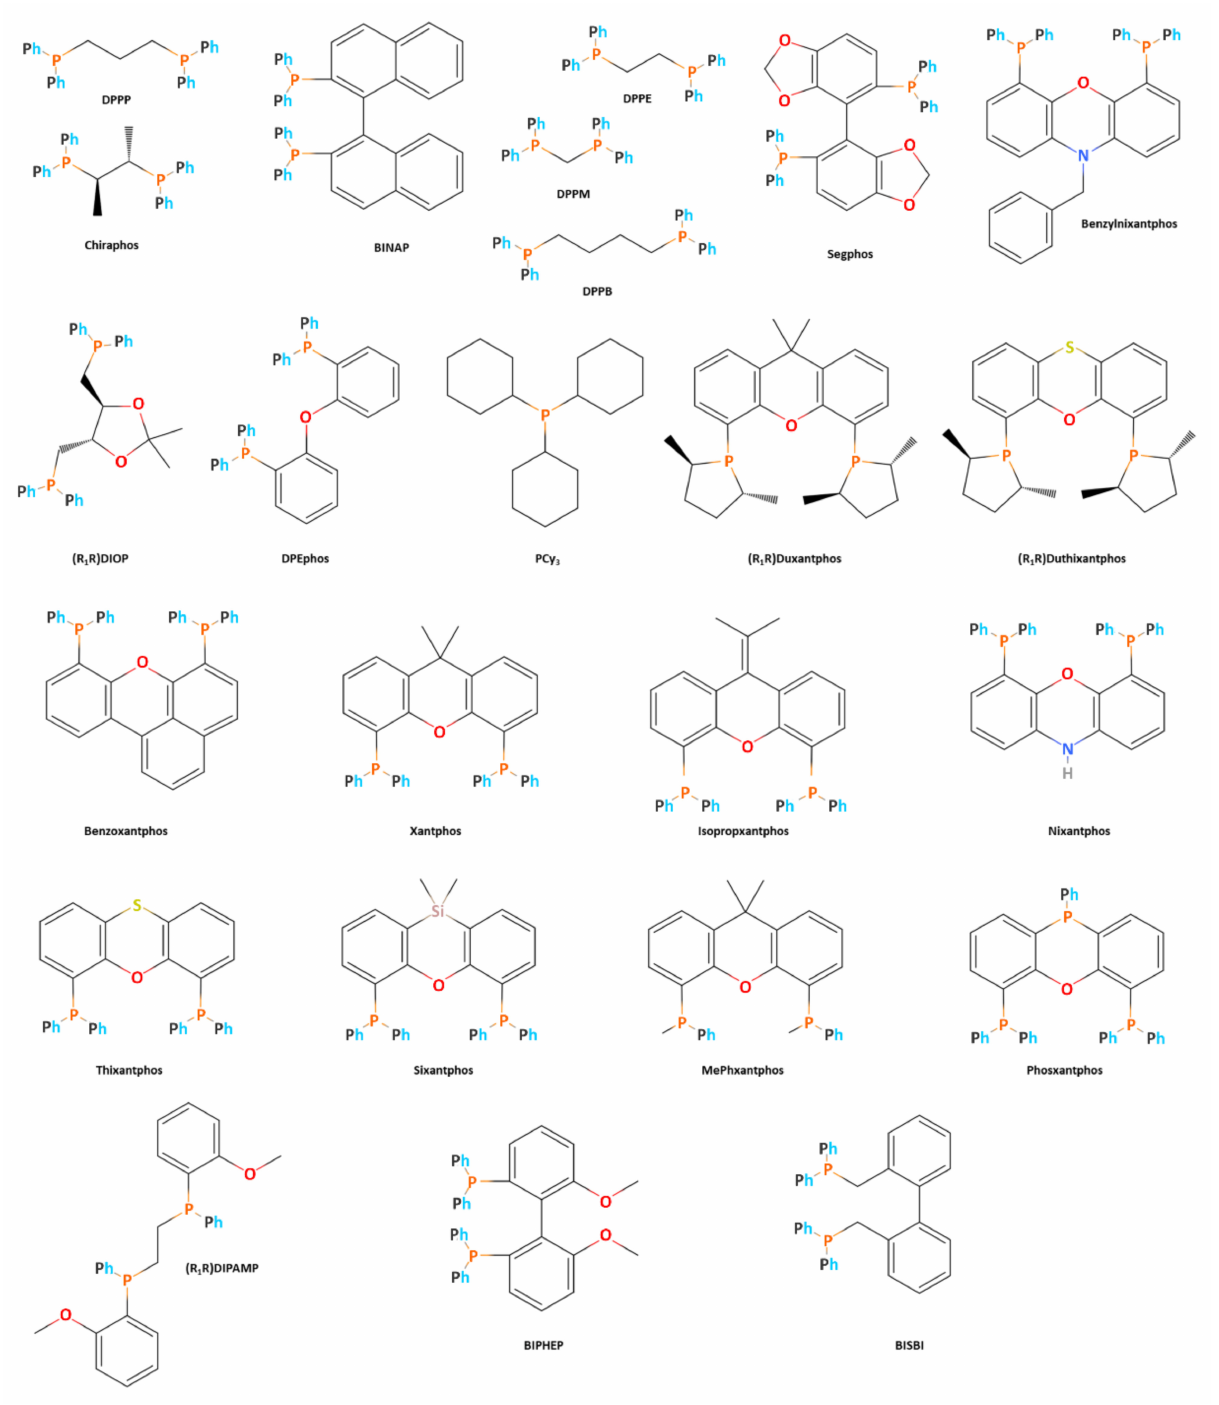
Chart 3. Molecular structures of the most used phosphines in